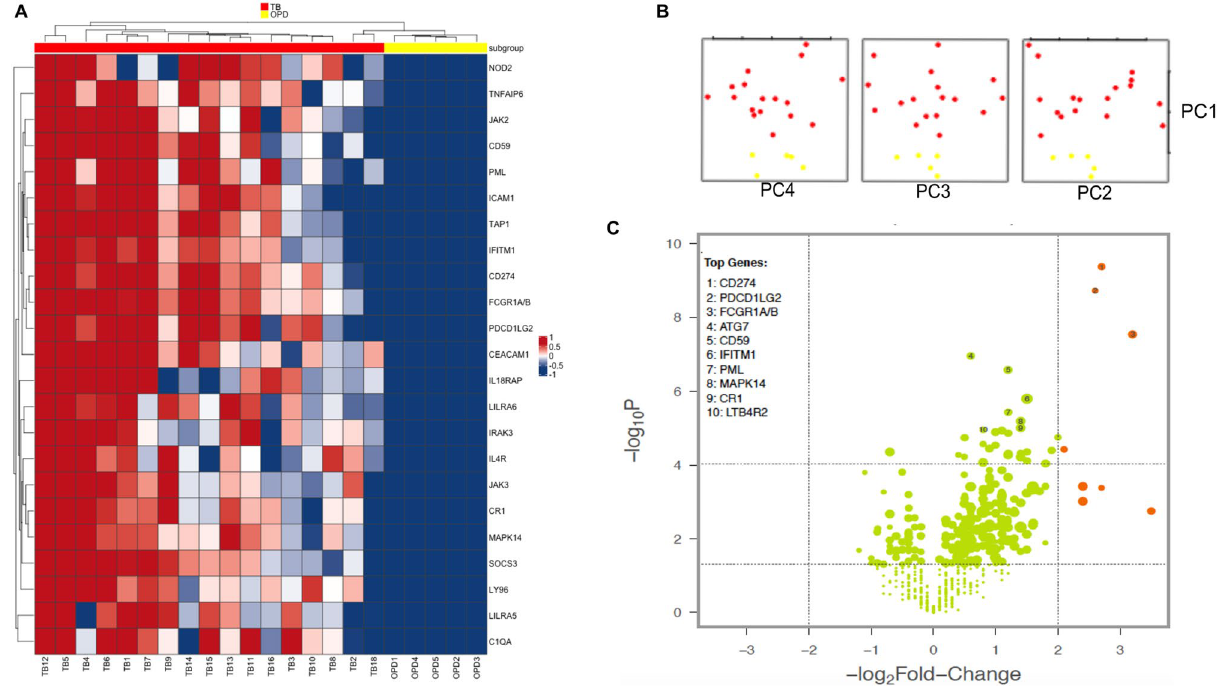
Figure 2. Identification of markers for TB diagnosis. ( A ) Heatmap of 23 gene expression levels of TB (red) and OPD (yellow) patients. ( B ) PCA score plot of TB and OPD patients. ( C ) Volcano plots showing the distribution of the gene expression fold changes in TB patients relative to OPD patients. Genes with absolute fold change ≥ 4 and p-value ≤ 0.05 are indicated in orange. Expression levels are scaled from dark blue (low expression) to dark red (high expression). Figures were generated with R (version 3.6.3) using ComplexHeatmap package (version 2.0.0, https ://bioco nduct or.org/packa ges/relea se/bioc/html/Compl exHea tmap.html), prcomp function from stats package (version 3.6.3, https ://www.r-proje ct.org/), and NanoStringNorm package (version 1.2.1.1, https :// cran.r-proje ct.org/web/packa ges/NanoS tring Norm/index .html) for heatmap, pca and Volcano plot,